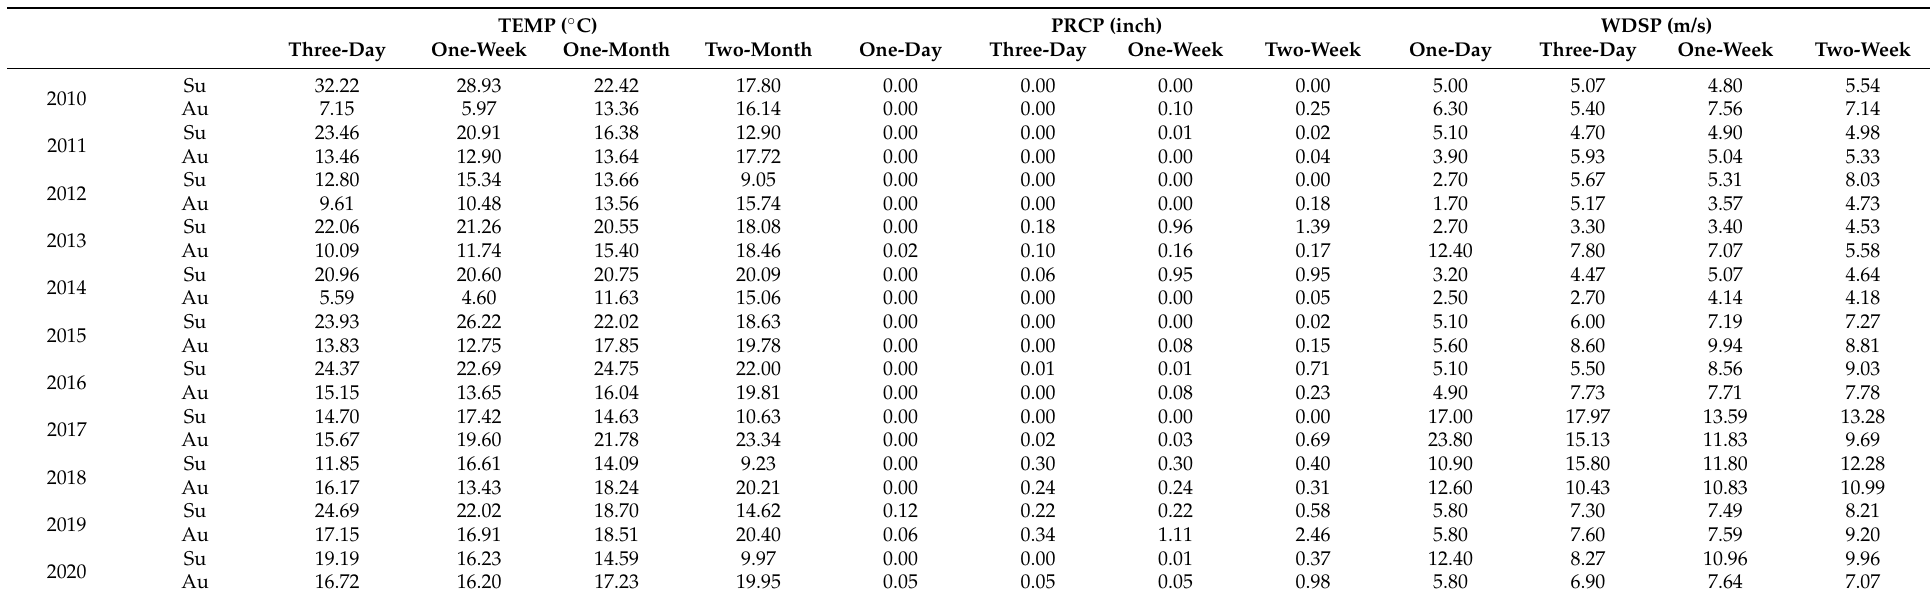
Table A3. Meteorological station data of Hulun